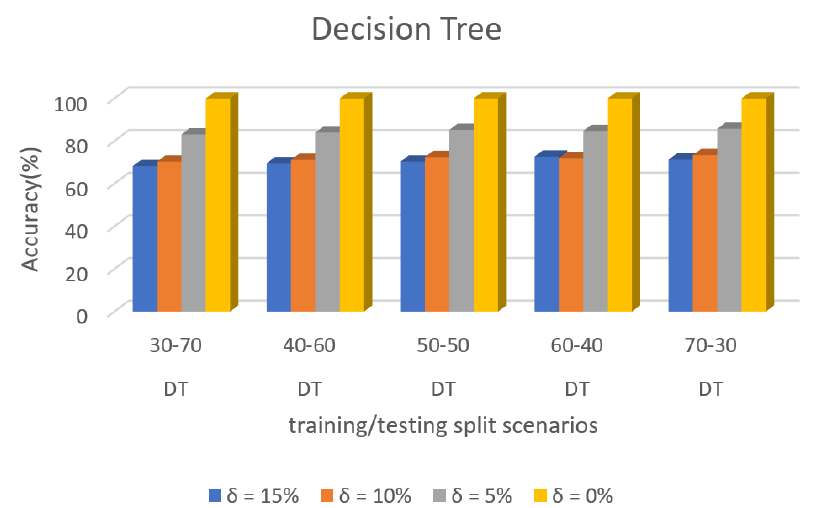
Figure 11. Accuracy Prediction for Dataset 1 using Decision Tree Algorithm.